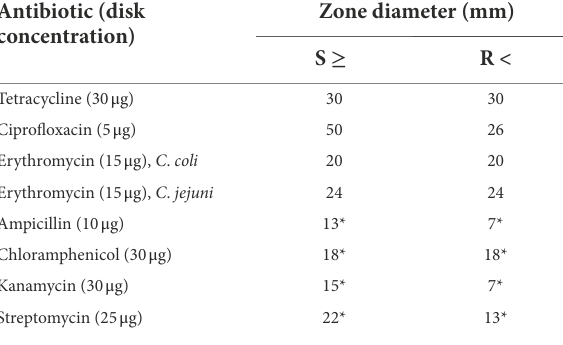
TABLE 1 Breakpoints used for determination of the antimicrobial resistance of C . jejuni and C . coli . Antibiotic (disk